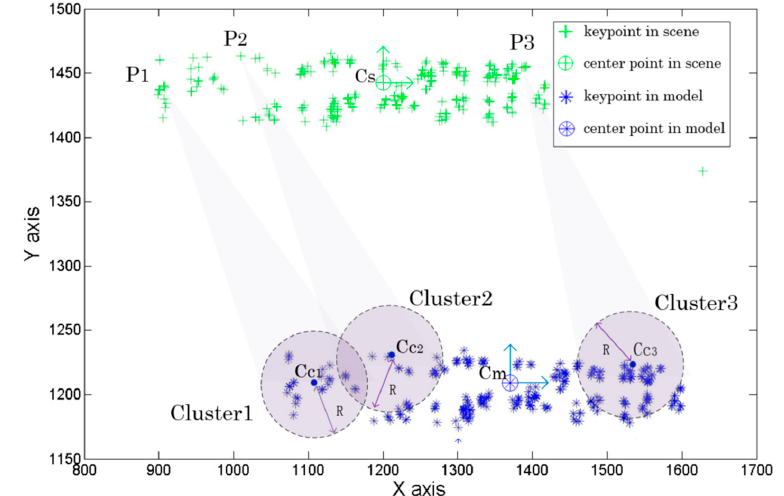
Figure 5. Keypoints matching based on spatial-consistency; corresponding searching cluster of every keypoint in scene image is restricted to a circular areal according to the spatial consistency → → P 1 Cs = C c1 Cm